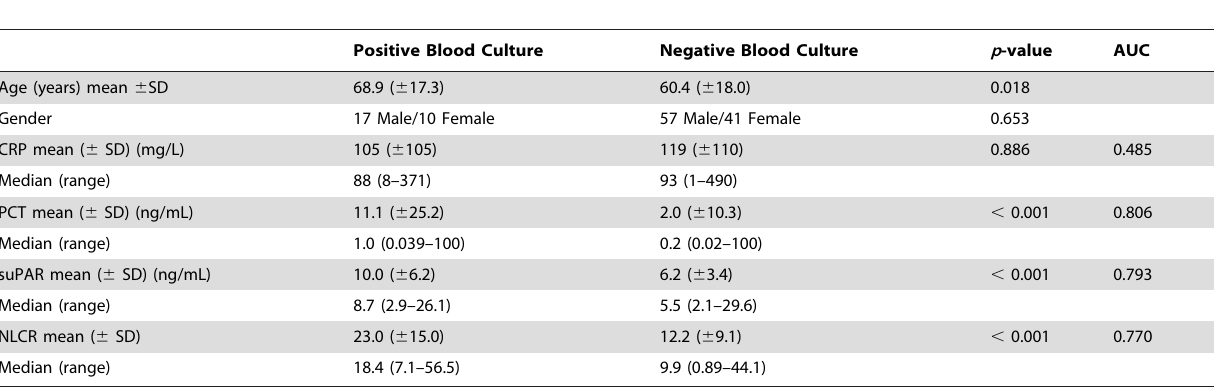
Table 2. Data of study population and results for C-reactive protein (CRP), procalcitonin (PCT), soluble urokinase plasminogen